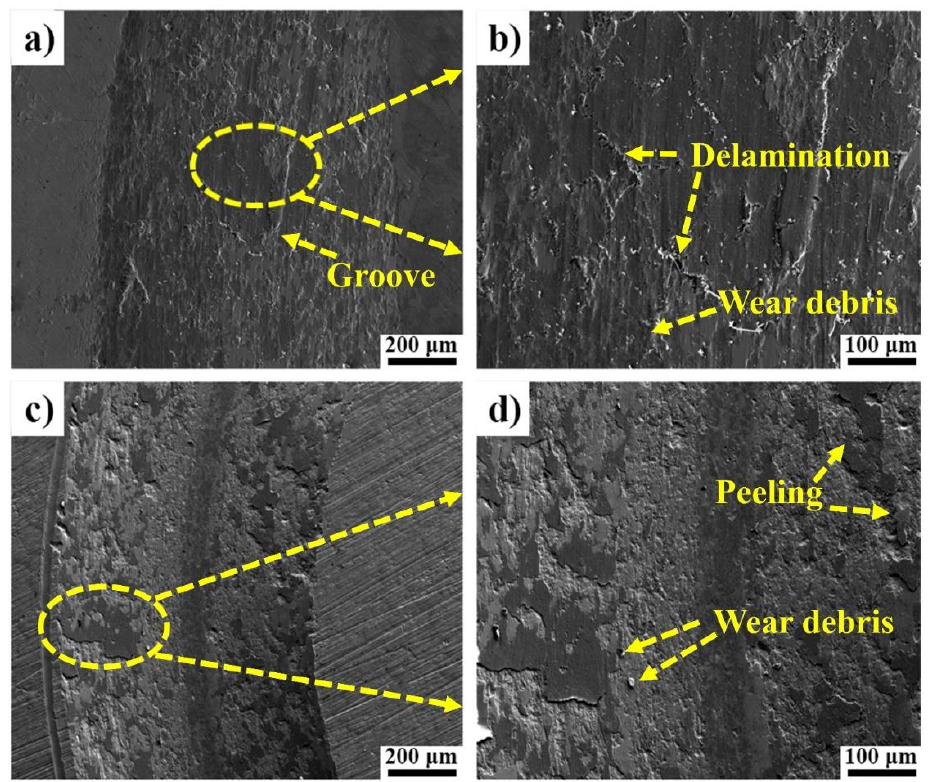
Figure 8. SEM images of Sn30 BHEA and Sn35 BHEA: ( a , b ) Sn30 BHEA, ( c , d ) Sn35 BHEA.